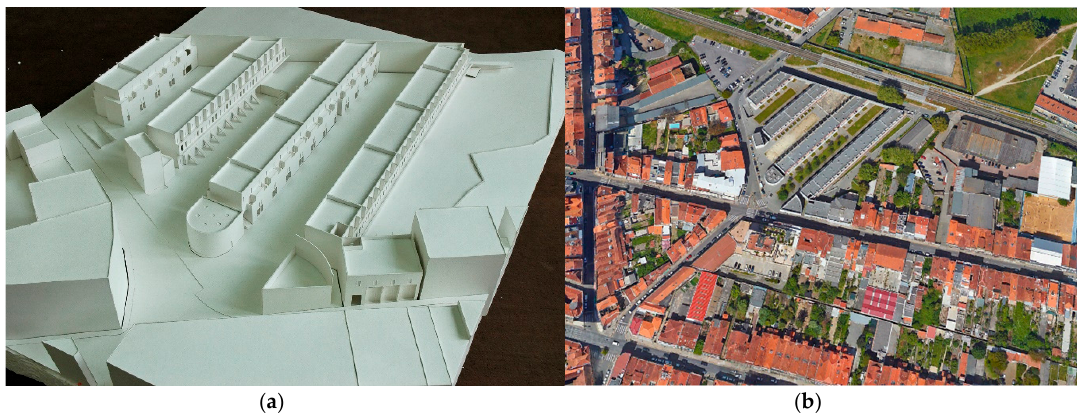
Figure 7. SAAL Estate of Bouça, Porto, Portugal, by Architect Alvaro Siza, 1st Phase 1973–78, 2nd Phase 1999–2006: ( a ) Model; ( b ) Aerial view, circa 2016.